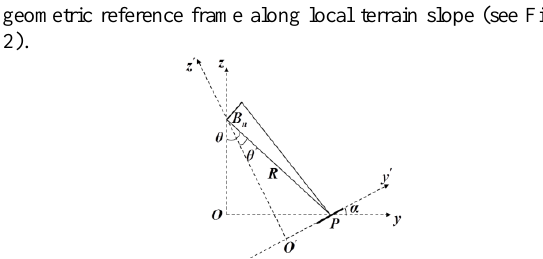
Figure 2. Geometric reference frame for S-RVoG